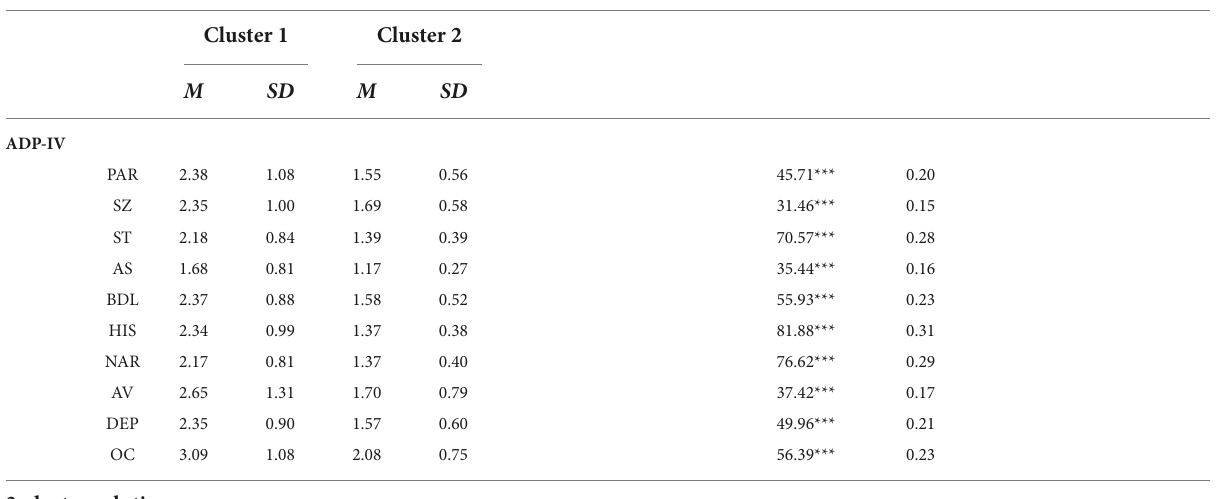
F Partial η 2 Post-hoc comparisons p <